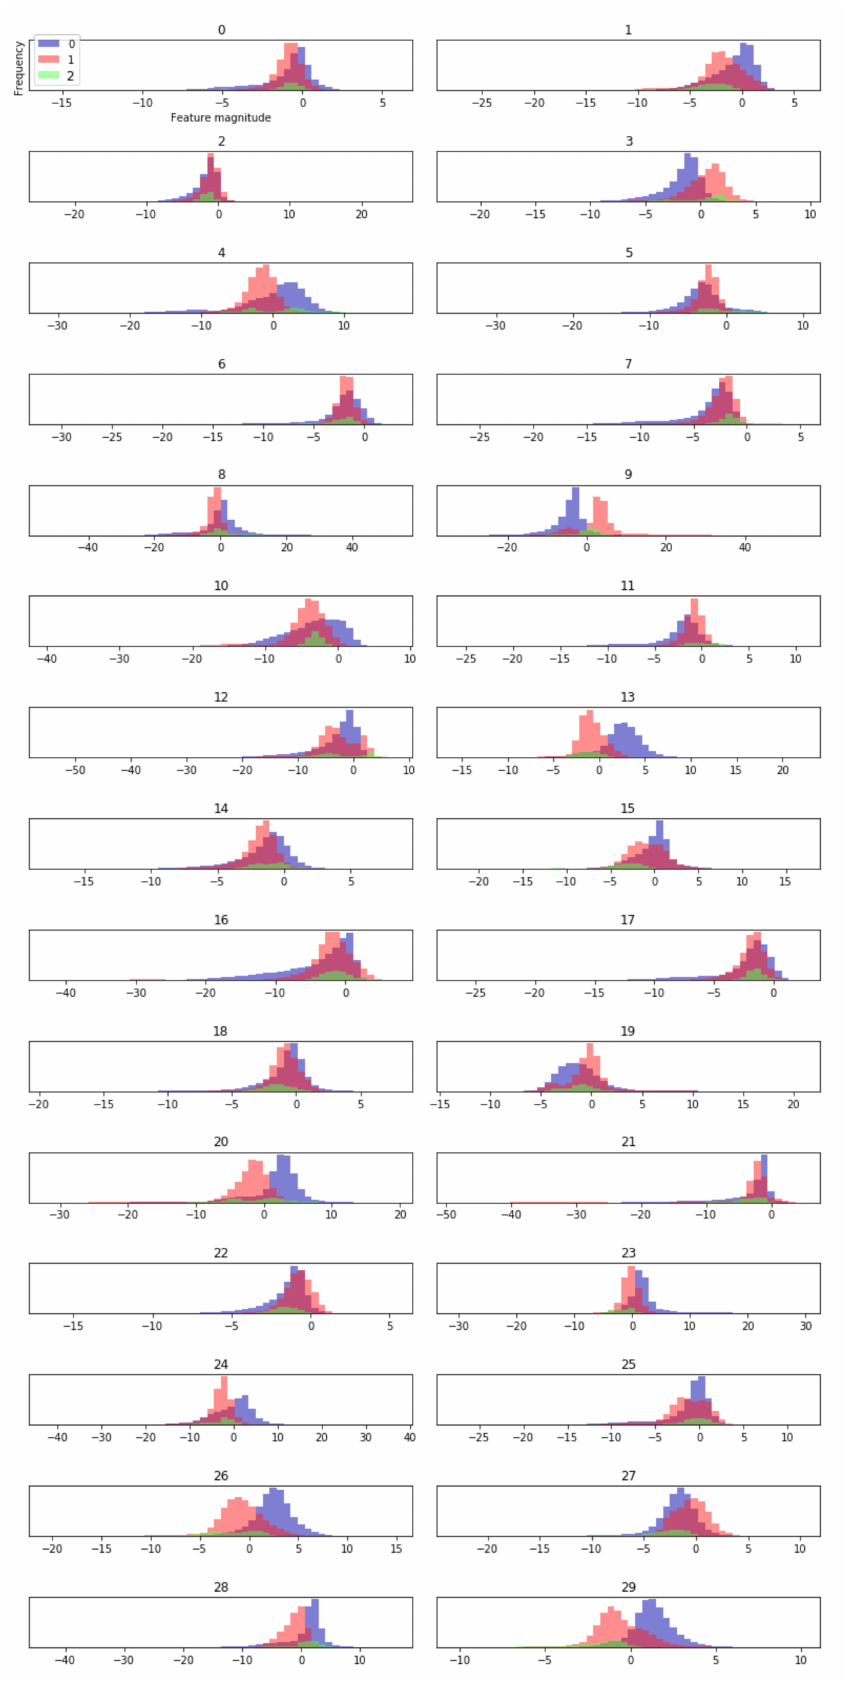
Figure 12. The histogram of features learned from the proposed model: 0 is small ship, 1 is big ship, 2 is